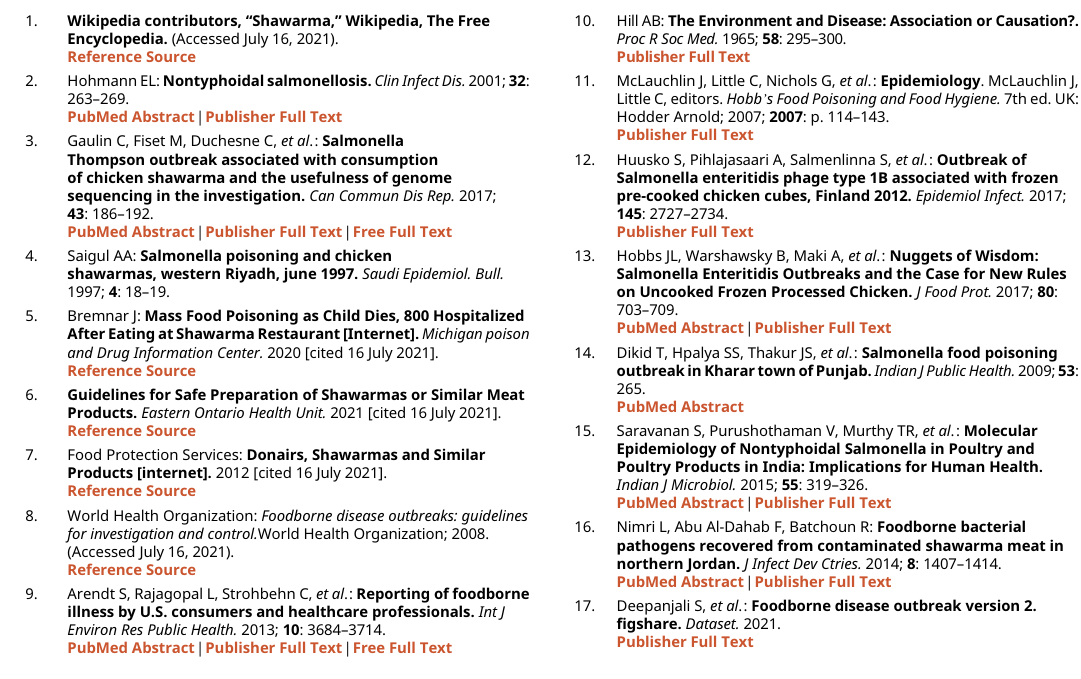
This project contains the following underlying